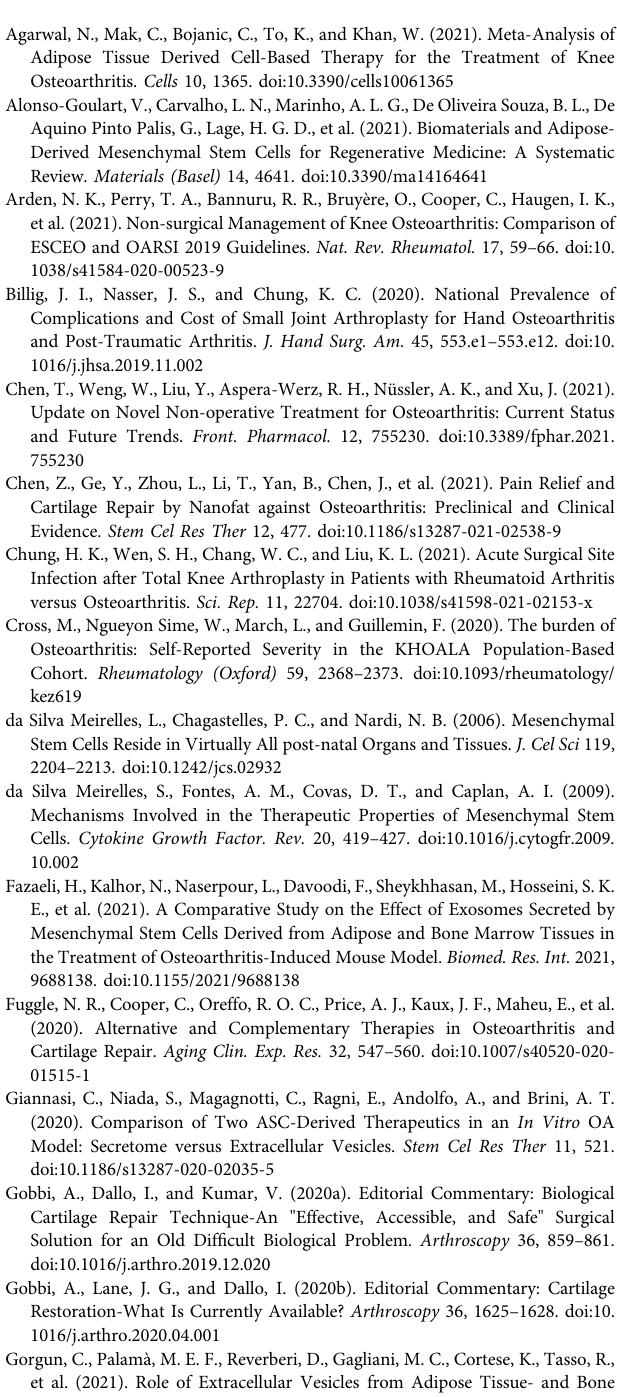
Supplementary Figure S2 | Flow cytometry analysis of ADSCs. Supplementary Figure S3 | OA scoring of knee joints after sodium hyaluronate treatment. VAS and WOMAC scores before (baseline) and after once intra-articular injection of sodium hyaluronate at week 2 (2W). Values were presented as mean ± SD. N =21. ** P < 0.01 vs. Baseline group.